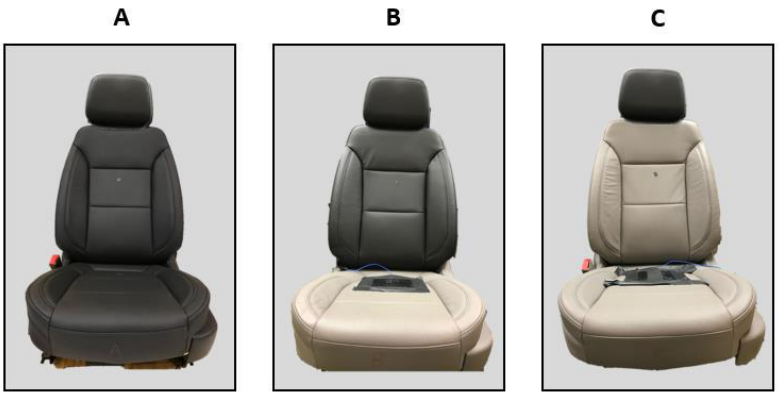
Figure 1. Three seats tested: Seat ( A ) (Left), Seat ( B ) (Middle), Seat ( C ) (Right). Table 1. Mechanical properties of the cushion foam